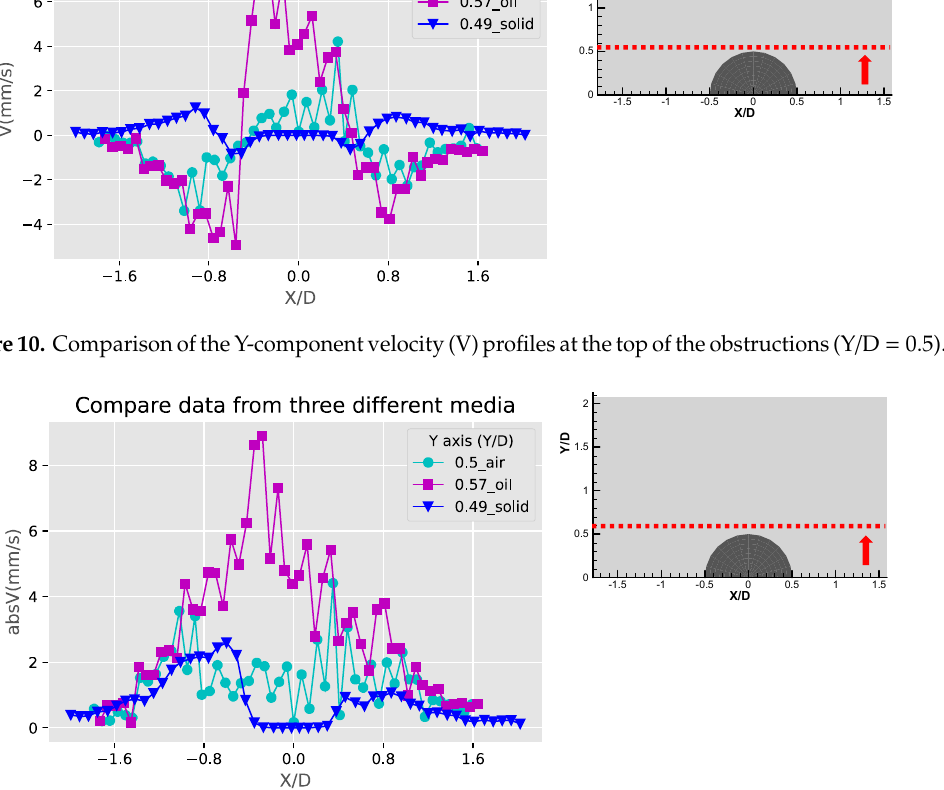
Figure 11. Comparison of the absolute velocity (absV) profiles at the top of the obstructions (Y/D ≅ 0.6).